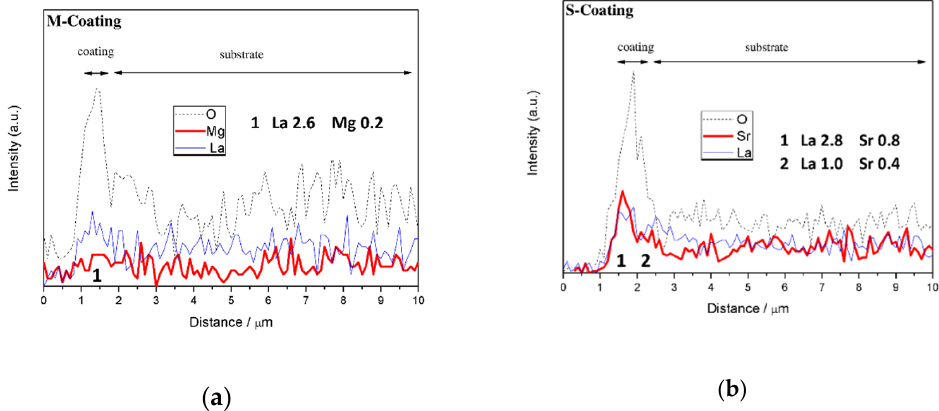
Figure 6. EDX line scans of O, La, Mg and Sr elements across the thin-film perovskite coating cross-sections for M-coating ( a ) and S-coating ( b ) samples. The chemical analysis is in atomic percent. According to the measured atomic ratio La:Sr = 2.8:0.8, the formula for the outer